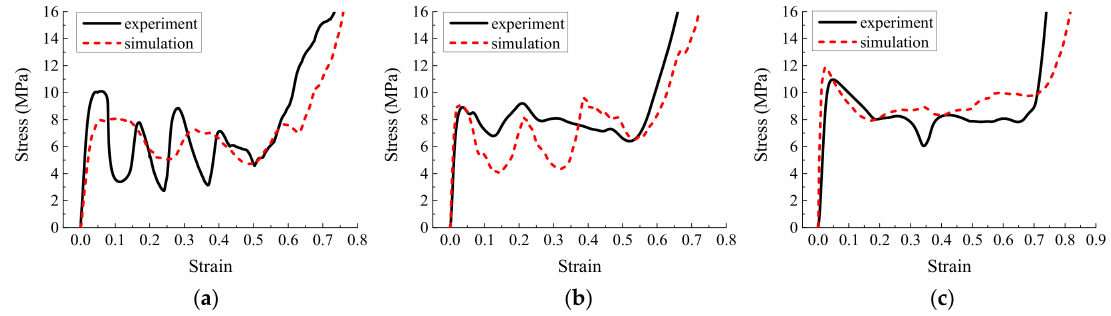
Figure 19. Simulation stress–strain results and experimental measurements of Specimen 1 ( a ) in the in-plane direction along the y -coordinate, ( b ) in the in-plane direction along the x -coordinate, and ( c ) in the out-of-plane direction.